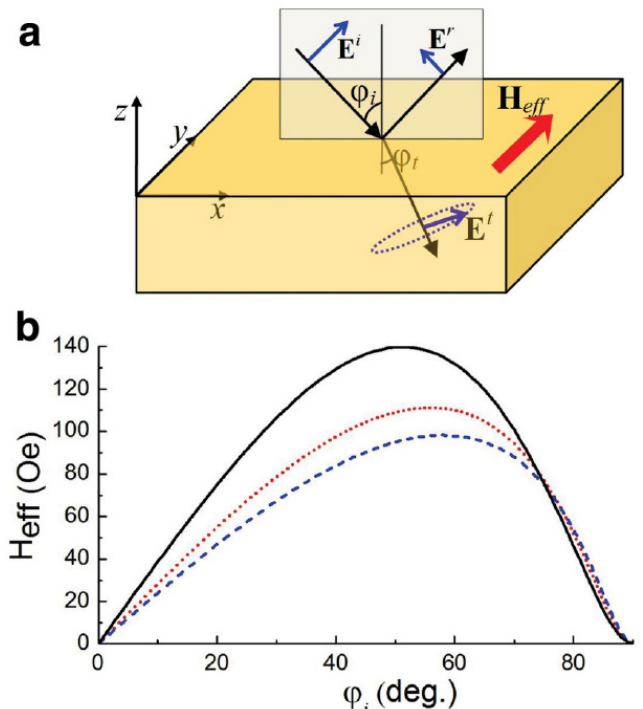
Figure 12. ( a ) Configuration for the inverse TMOKE. p -polarised light is obliquely incident on the ferromagnet film and generates an effective magnetic field H film; ( b ) The inverse TMOKE near the surface (at a point 5 nm in depth) of the magnetic films of iron (black solid line) at λ = 630 nm, nickel (red dotted line) at λ = 630 nm, and bismuth iron garnet (BIG) (blue dashed line) at λ = 400 nm as a function of angle of incidence of light. It is assumed that the samples are illuminated with a 40 -fs duration laser pulse with a peak intensity of 500 W/ µ m 2 . Reproduced from [133] with permission by American Physical Society, Copyright